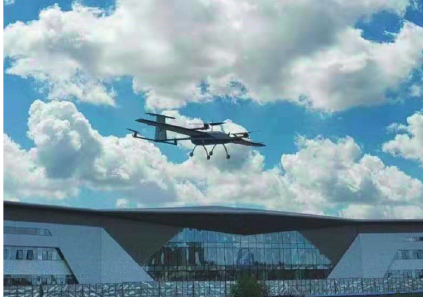
Figure 14: Hovering flight test photo.